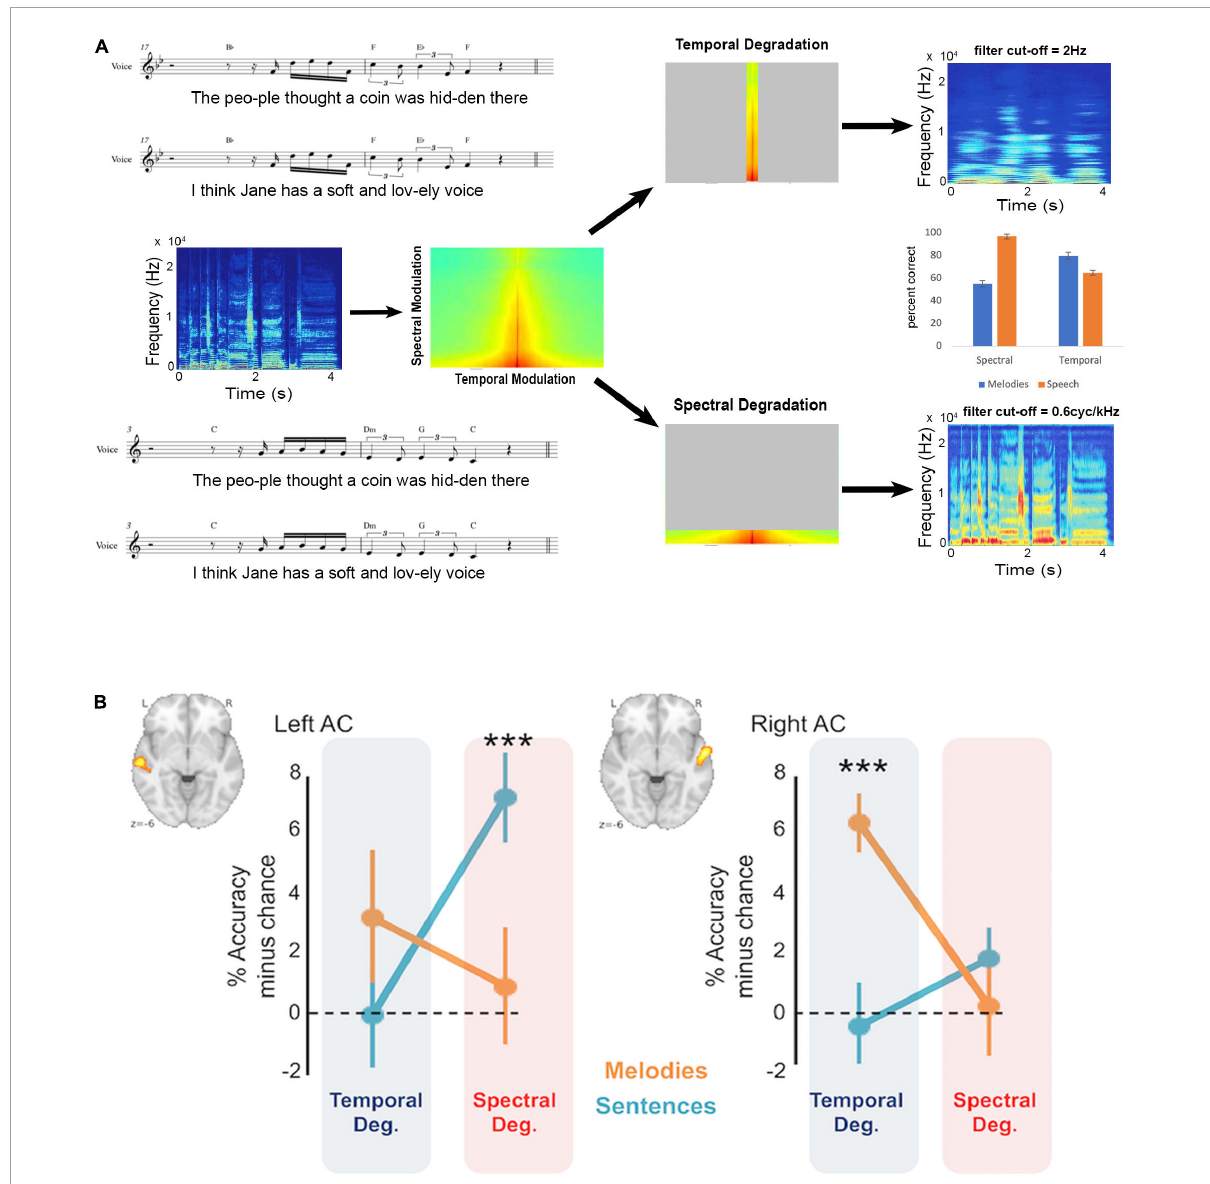
FIGURE1 Behavioral and neural effects of spectrotemporal degradation in music and speech. (A) Sung stimuli (music notation) consisted of the same tunes sung to different phrases or vice-versa, yielding an orthogonal set of songs with matched melodic and speech content. These songs (spectrogram and spectrotemporal plots in middle panel) were then degraded either in the temporal domain, leaving spectral modulation intact (top), or vice-versa (bottom). The effect of this manipulation can be seen in the resulting spectrograms (right side) where the temporal degradation smears the temporal information but leaves spectral information intact, while spectral degradation smears the spectral information but leaves temporal information intact. The behavioral result (middle panel bar graph) shows that behavioral performance for melodic content is severely reduced after spectral compared to temporal degradation (blue bars) while performance for speech is reduced after temporal compared to spectral degradation (orange bars). (B) In the left auditory cortex, functional MRI classification performance for decoding speech content is reduced to chance only after temporal degradation; while in the right auditory cortex functional MRI classification performance for decoding melodic content is reduced to chance only after spectral degradation, paralleling the behavioral effects shown in panel (A) . Adapted with permission from Albouy et al. (2020). ***Refers to significantly above chance